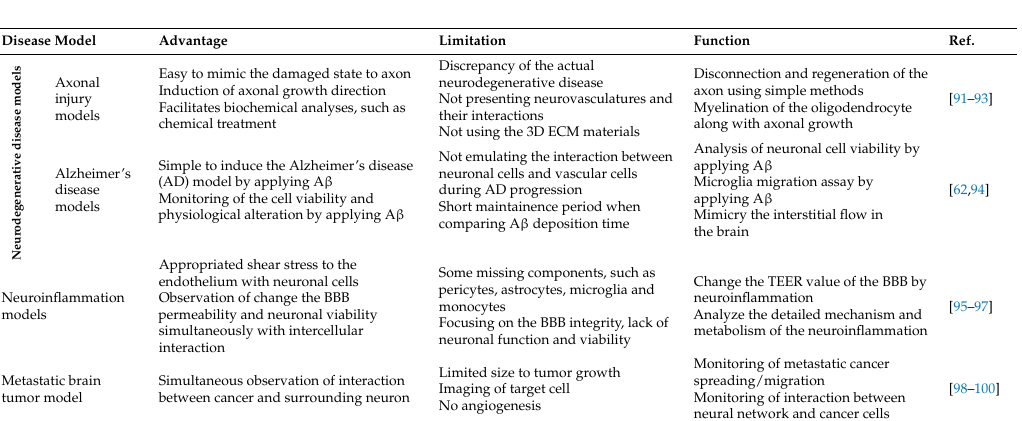
Table 2. Advantages and limitations of current disease models on a